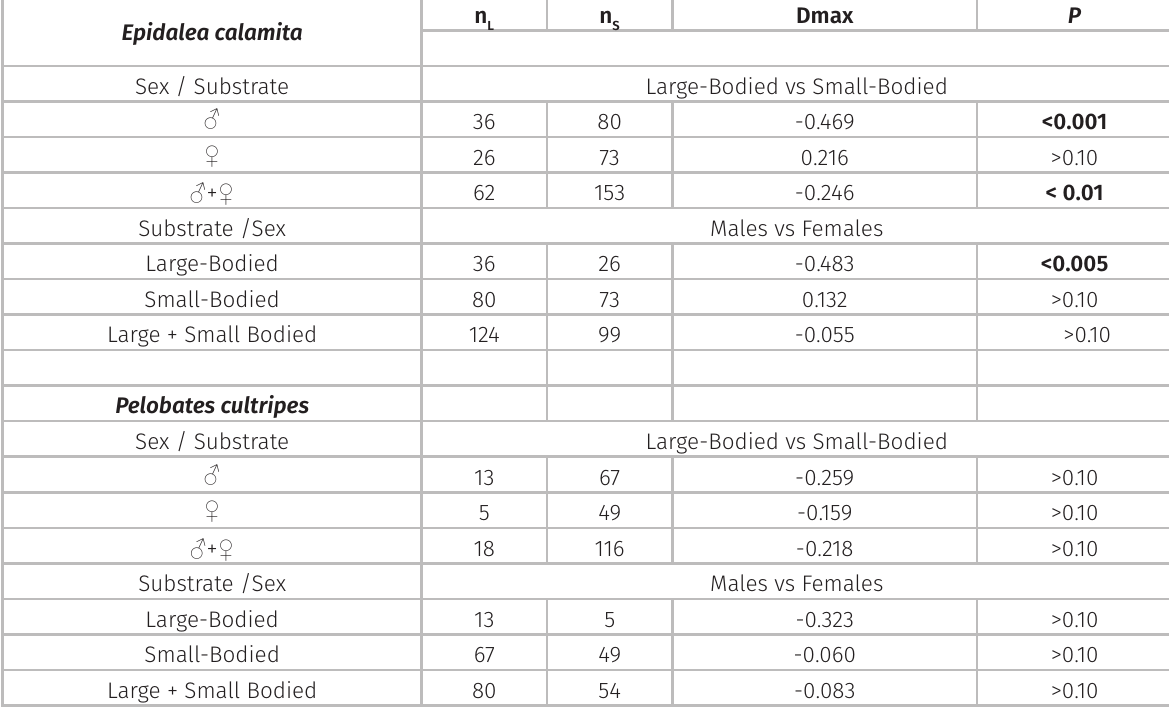
Table II. Comparison of frequency distributions of age between substrates (Hercinic; large-bodied populations; Sandy: Small-bodied populations) by sex (a), and between sexes within substrate. n Small-bodied individuals, respectively (b). Kolmogorov-Smirnov test frequency. Significant values are highlighted in